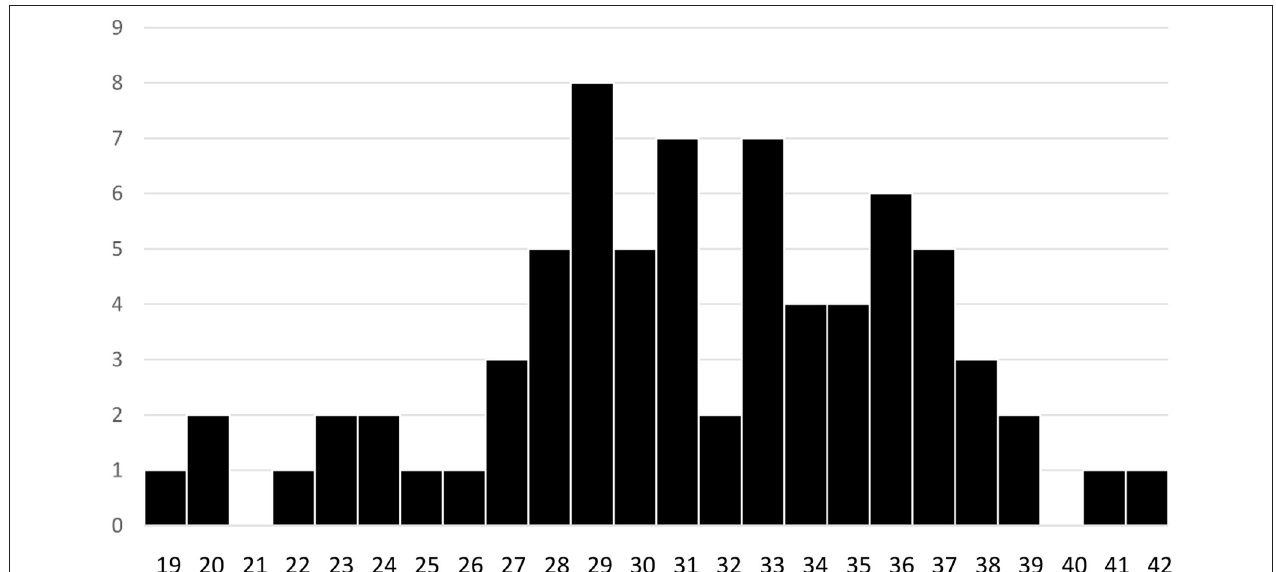
FIGURE 3 | Ages of participants considering freebirth.